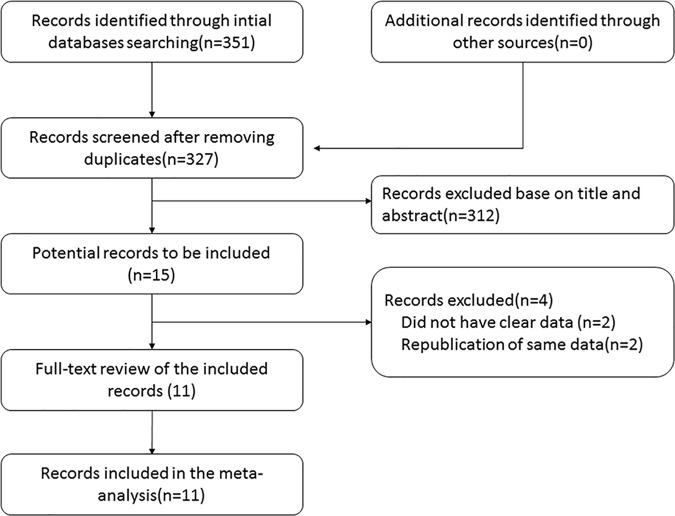
Flow chart for study search (PRISMA diagram).